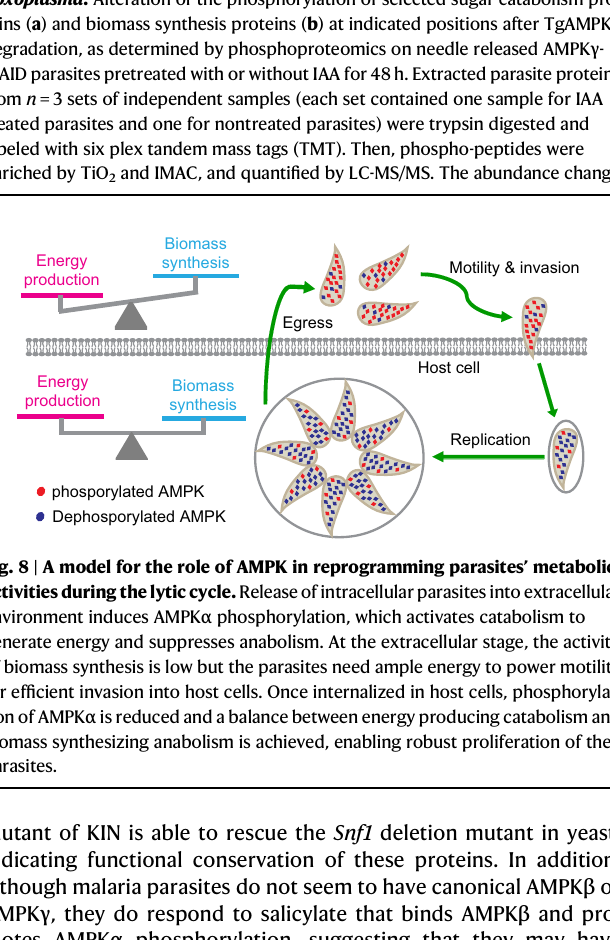
(expressed as log 2 fold change) and the corresponding p -value (determined by EmpiricalBayestwo-tailedtestsinthelimmapackage)(expressedas-Lg p -value)of each phospho-peptide after TgAMPK γ depletion (+IAA/-IAA) were plotted.